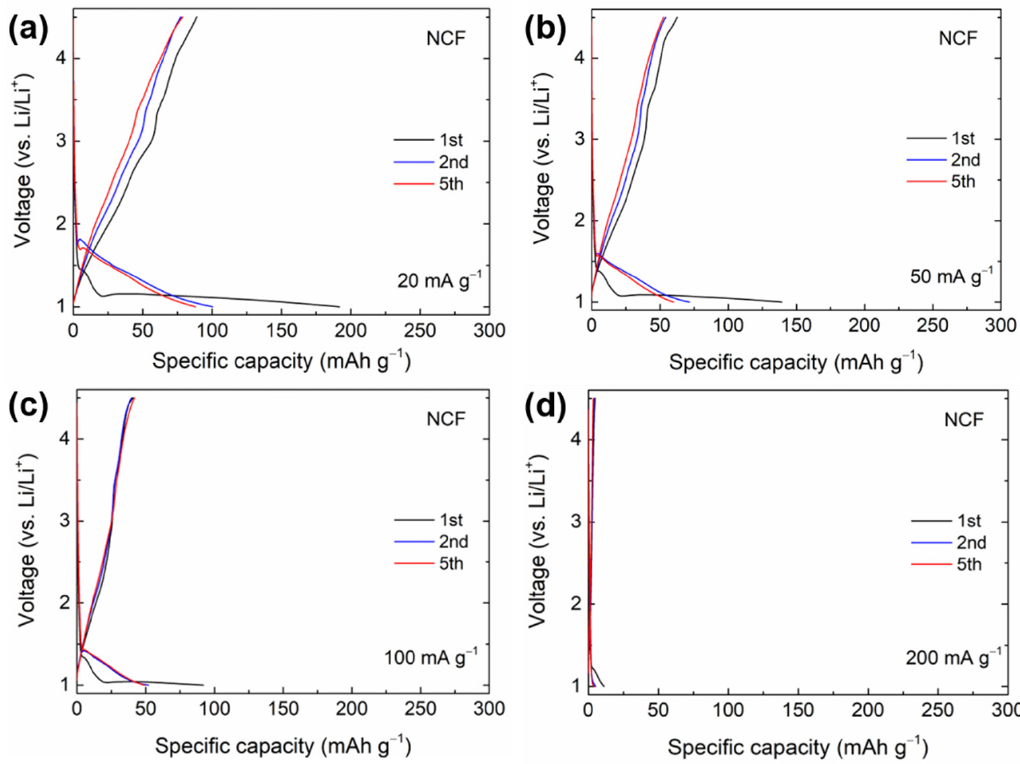
Figure 5. Galvanostatic charge/discharge curves of the 1st, 2nd, and 5th cycles for the NCF electrode at a current density